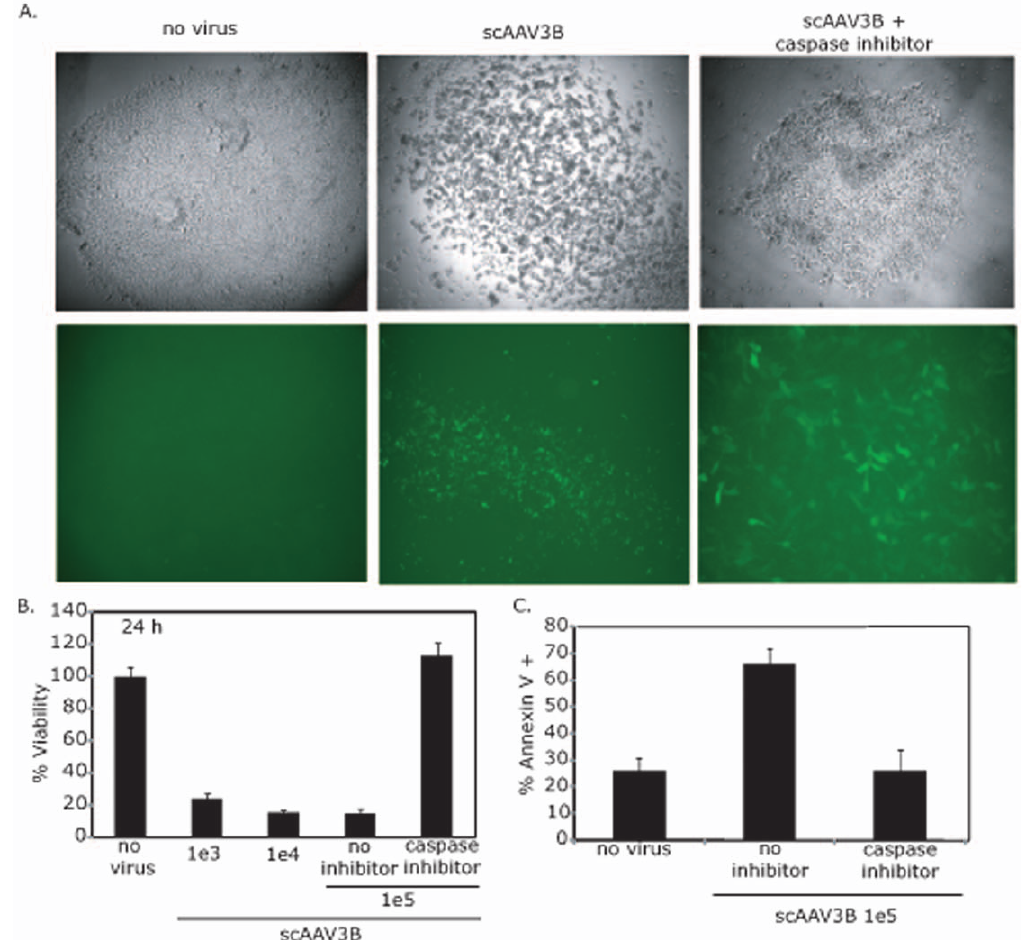
Figure 2. Recombinant AAV Transduction of hESCs induces Apoptosis. Human embryonic stem cells (hESCs) were treated with 100,000 AAV3B particles packaged with a self-complementary CMV- egfp genome. 24 h post-infection (p.i.) cellular morphology and GFP fluorescence was observed by microscopy in the presence or absence of a pan-caspase inhibitor (A). Cell viability of hESCs treated with the indicated amount of the scAAV3B- egfp vector described above was analyzed by dye exclusion 24 h post-infection (B). Significant decreases (p-value , 0.05) were noted in